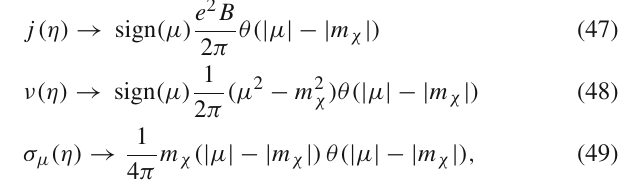
Fig. 6 Behavior of ˜ σ(η) as a function of T / √ | eB | = π/ 40. The solid (black) curve corresponds to 0 . 5 and μ/ the numeric expression in Eq. (28). The long-dashed (red) curve cor- responds to the weak field limit in Eq. (29). The short-dashed (blue) curve to the strong field expansion in Eq.